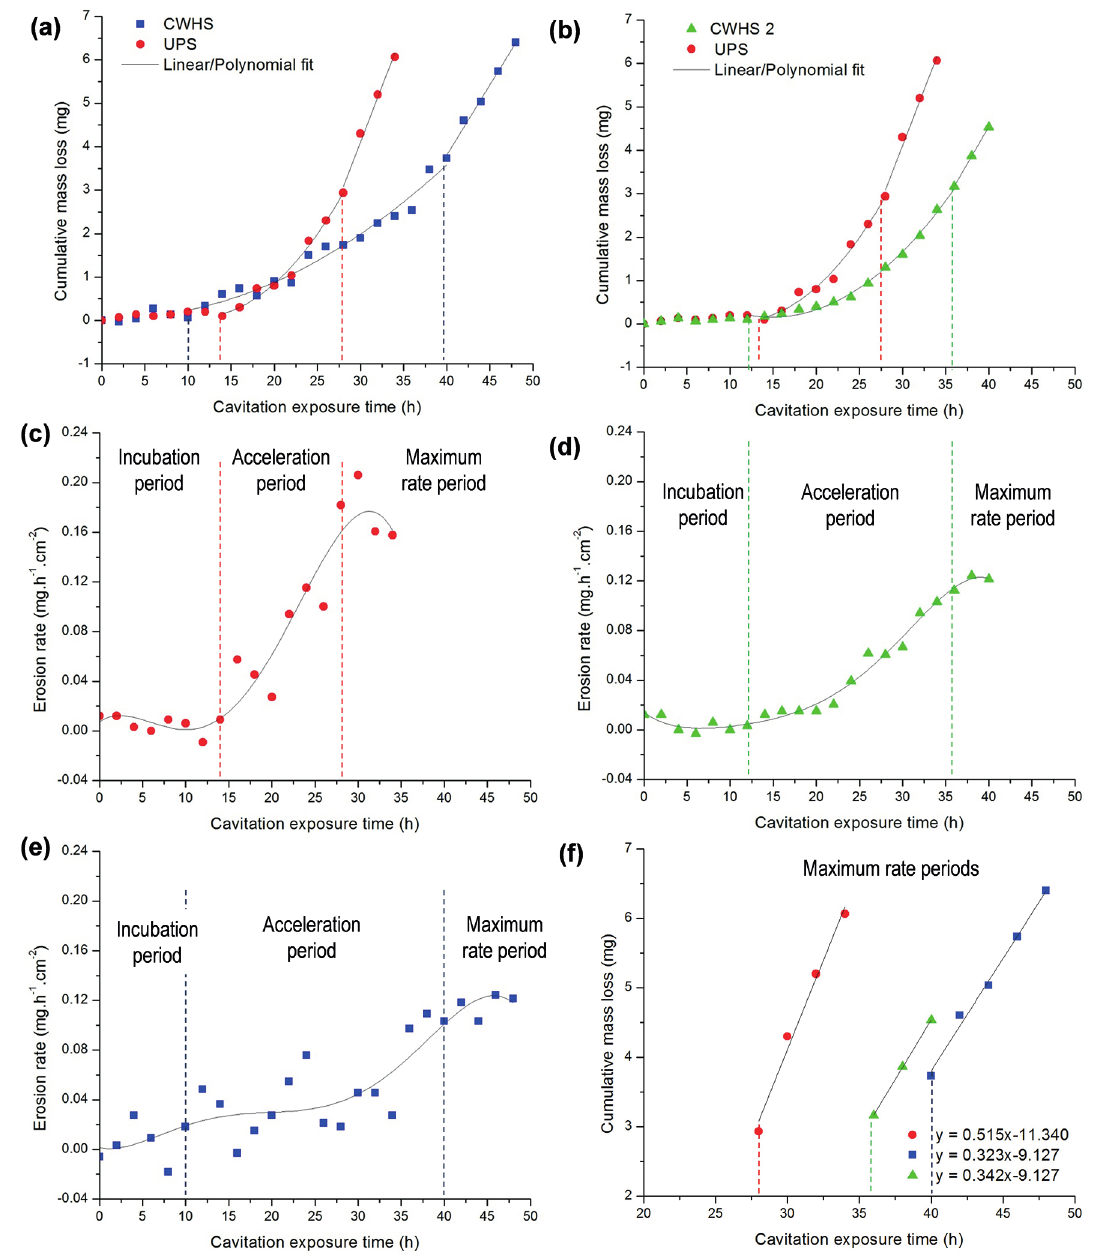
Figure 10: Cumulative mass loss and erosion rate over cavitation time for UPS, CWHS 1 and CWHS 2 specimens of Set 2. Extension of the acceleration period induced by the cold work hardening